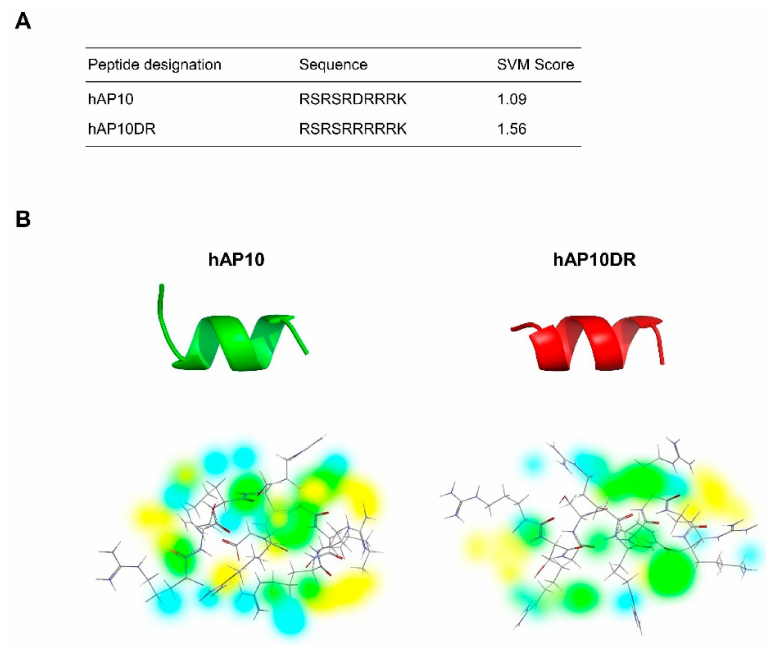
Figure 1. Sequence and structural prediction of the investigated peptides. ( A ) Name, amino-acid sequences and support vector machine (SVM) score of the potential CPPs. The SVM-based method, which uses binary profile of the peptide, was used for the SVM score prediction. ( B ) Top: Structural prediction of hAP10 and hAp10DR. Bottom: Energy maps of hAP10 and hAP10DR. Coloring is the following: hydrogen donor favorable (yellow), hydrogen acceptor favorable (blue) and steric favorable